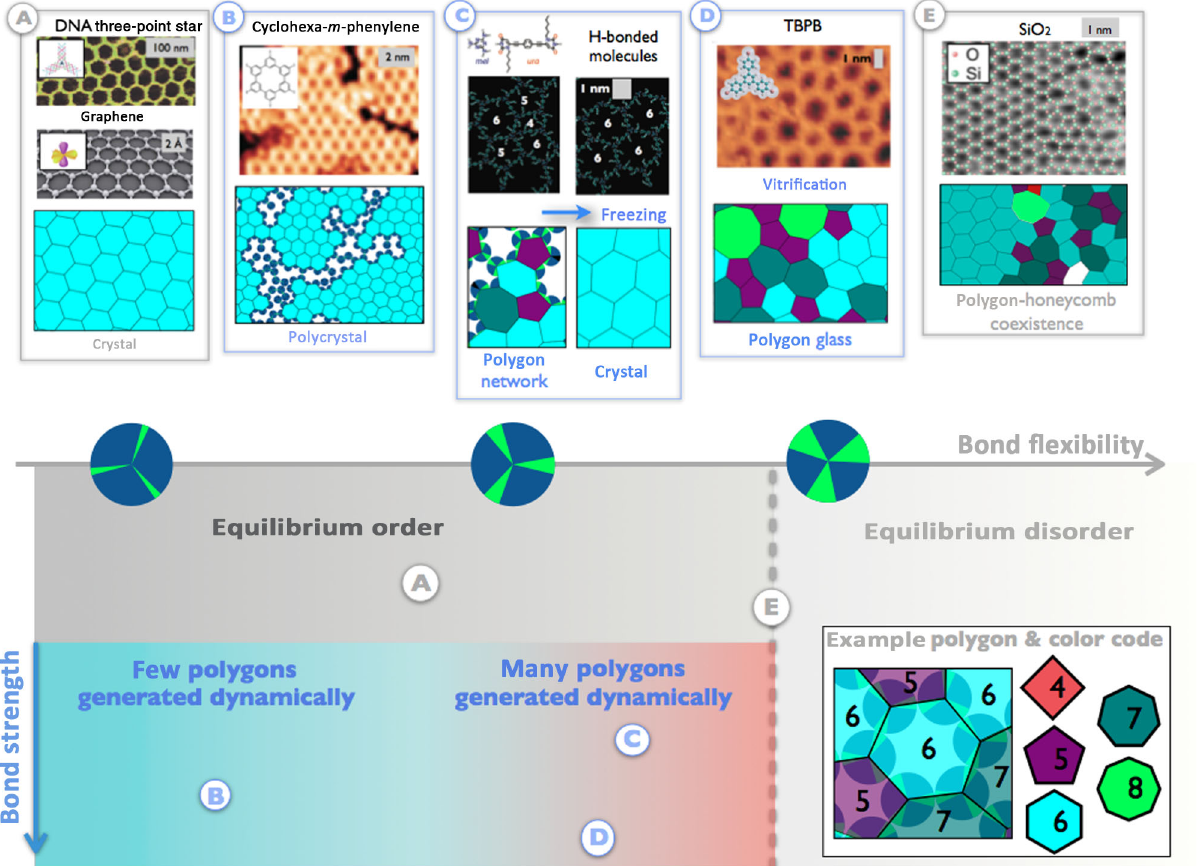
FIG. 1. Spanning a length scale of 3 orders of magnitude, the networks formed by a diverse collection of building blocks can be reproduced in simulation by accounting only for the geometry and strength of building-block interactions. Threefold-coordinated building blocks can, in equilibrium, form (A) the periodic honeycomb network [6,7] or (E) a nonperiodic polygon network [8]. Dynamically, they can self-assemble as (B) honeycomb polycrystals [9], (C) a polygon network that evolves to the honeycomb [10], or (D) a kinetically trapped polygon-network glass. Model building blocks whose interactions (parametrized by strength ϵ and flexibility w ) are motivated by quantum mechanical calculations (Fig. 2) can reproduce this spectrum of behavior. In equilibrium (grey lettering), such building blocks form the honeycomb network when their interactions are inflexible and a polygon network when their interactions are flexible (Fig. 3). Dynamically (blue lettering), within the regime of equilibrium-network order, building blocks self-assemble as honeycomb polycrystals when their interactions are inflexible (few polygons are generated dynamically) and as a polygon network when their interactions are flexible (many polygons are generated dynamically). If their interactions are weak, then the network evolves to the honeycomb; if their interactions are strong, then the network formed is a polygon glass (Figs. 4 and 5). Image permissions for Fig. 1: Panel A, top, reprinted (adapted) with permission from Ref. [7], copyright 2005, American Chemical Society. Panel B (experimental image) reproduced with permission from Ref. [9], copyright 2009, The Royal Society of Chemistry. Panel C (experimental image) reprinted (adapted) with permission from Ref. [10], copyright 2010, American Chemical Society. Panel E (experimental image) reprinted from Ref. [8], copyright 2012, The American Physical